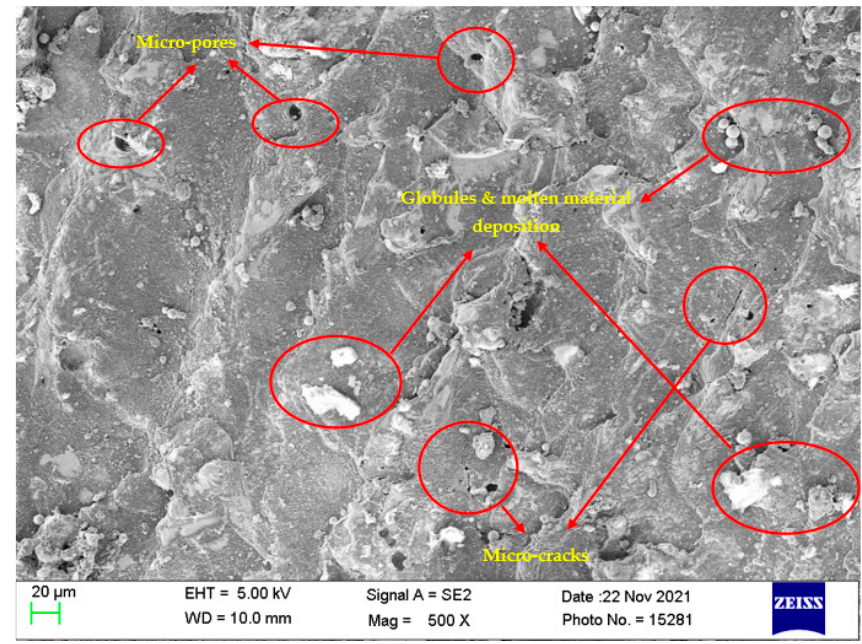
Figure 9. Surface morphology at T on = 31 µs, T off = 12 µs, and Al 2 O 3 amount = 1 g/L.